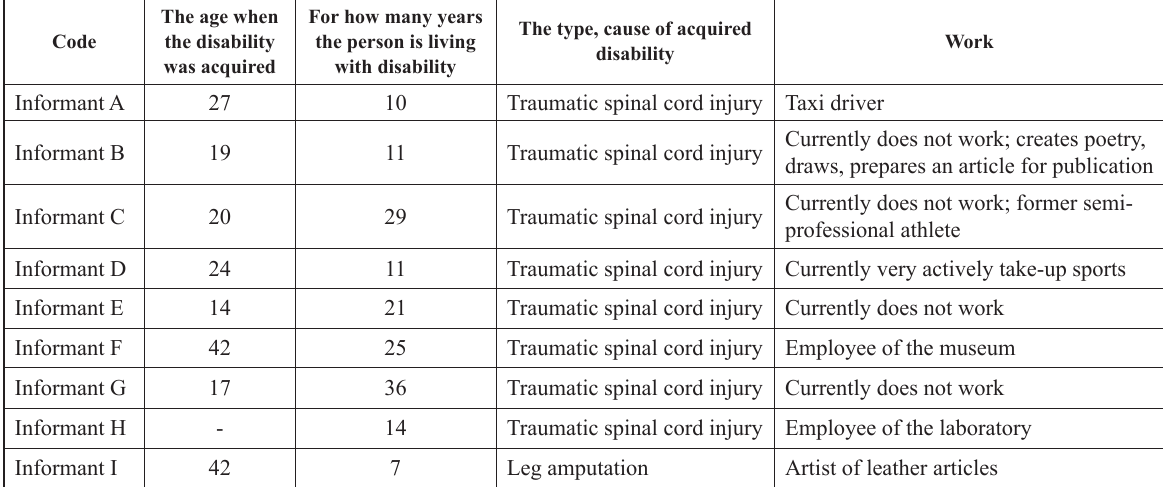
Table 1. Sociodemographic data on informants